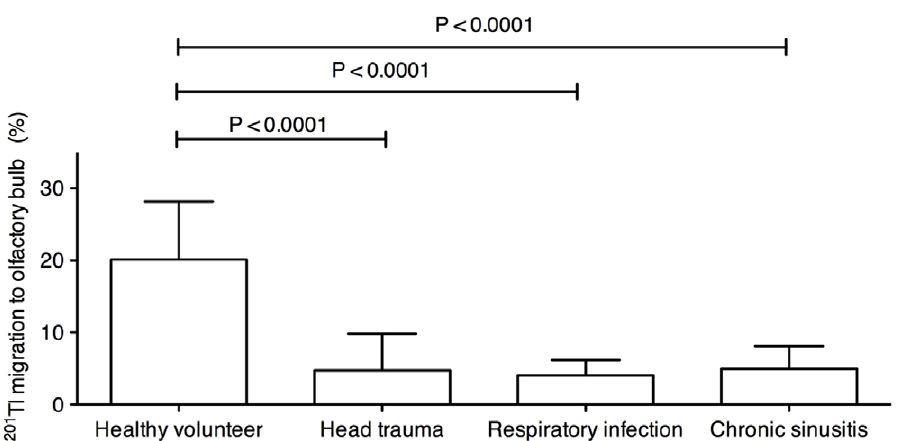
Figure 1. 201 Tl migration in patients with impaired olfaction in comparison to healthy volunteers. Nasal 201 Tl migration to the olfactory bulb in healthy volunteers (n=10) and patients with impaired olfaction due to head trauma (n=7), upper respiratory tract infection (respiratory infection; n=7), or chronic rhinosinusitis (n=7). P values were obtained with Bonferroni’s multiple comparison test and the Kruskal-Wallis test. Bars: Mean 6 S.D.